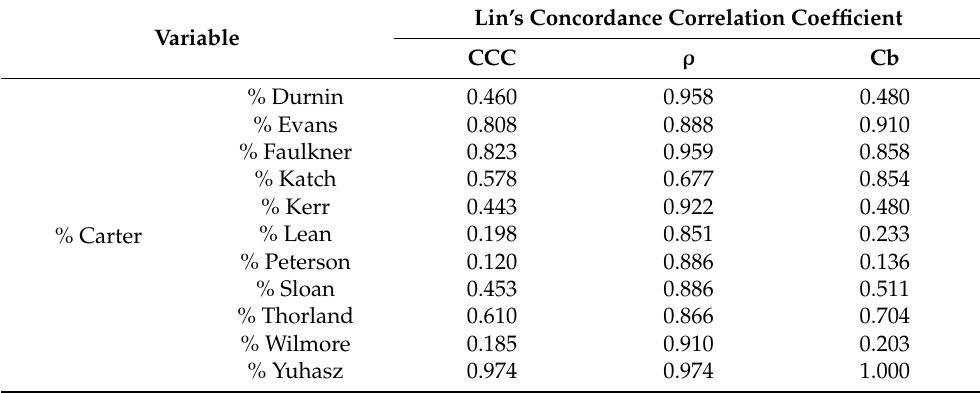
Table 6. Lin’s concordance correlation coefficient between the different formulas in